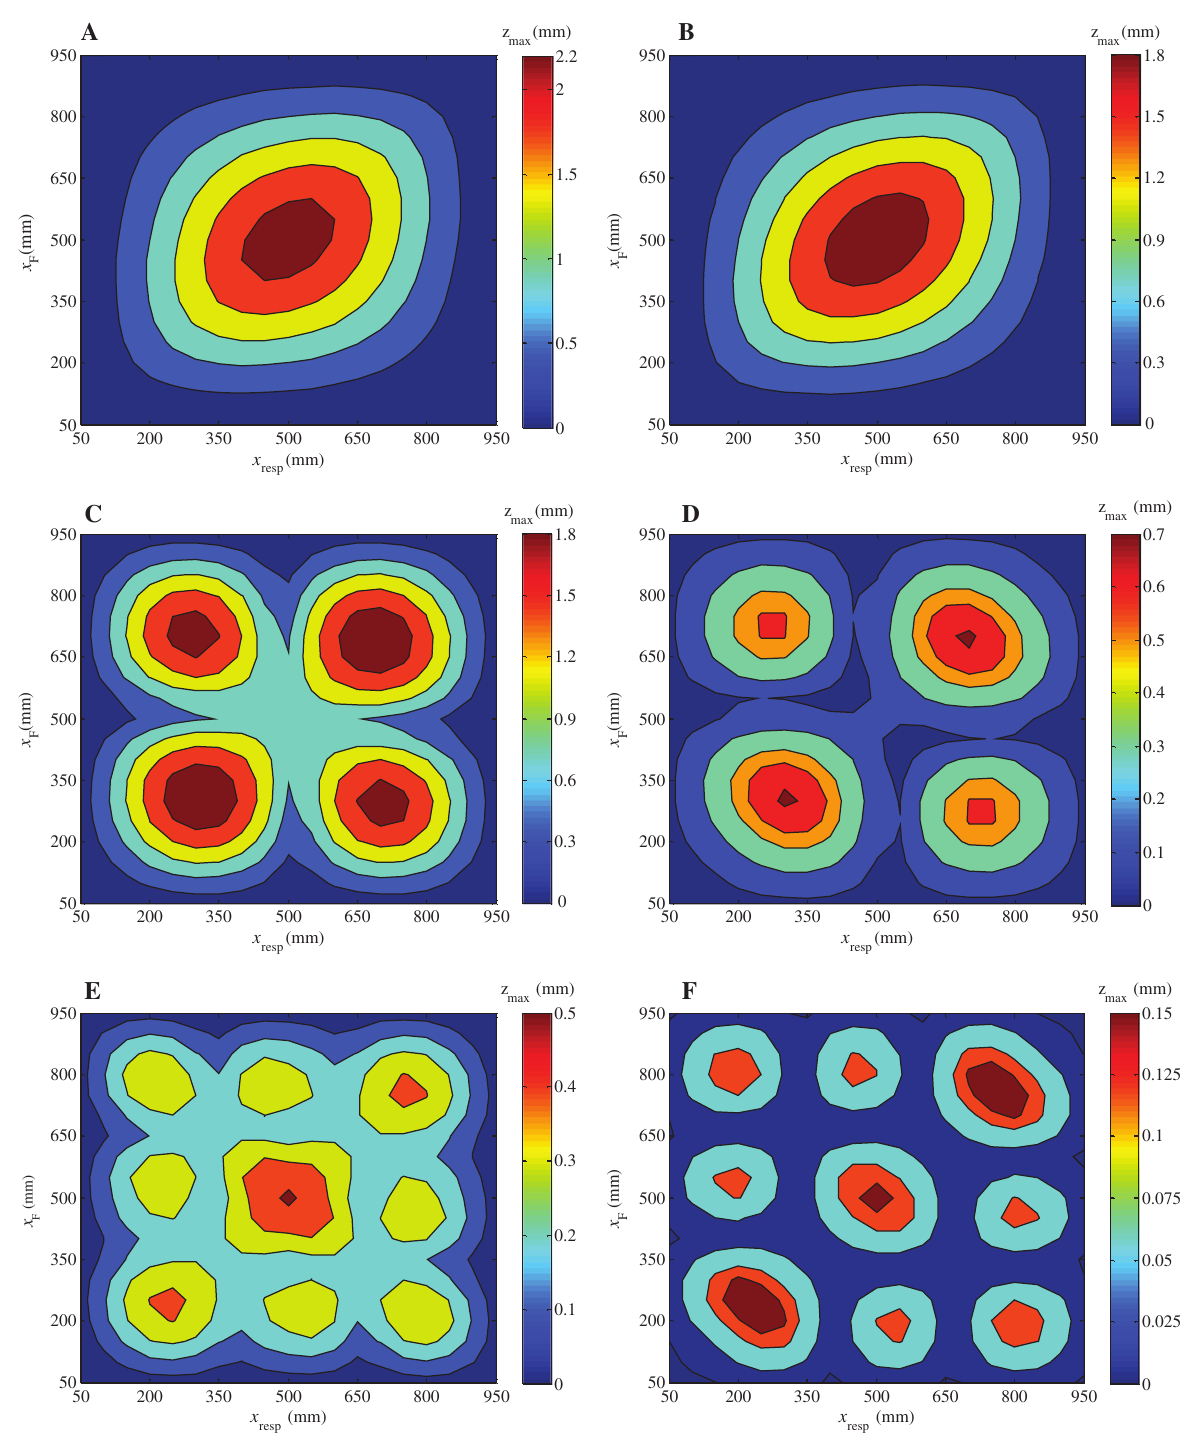
lay-up (A) 5 Hz, ζ = 0.0, (B) 5 Hz, ζ = 0.02, (C) 50 Hz, s Figure 4B, damping removes the transient effects in short time duration and the beam vibrates harmonically at the excitation frequency. Figure 4C and D shows the harmonic response at 11.5 Hz. This frequency value is very close